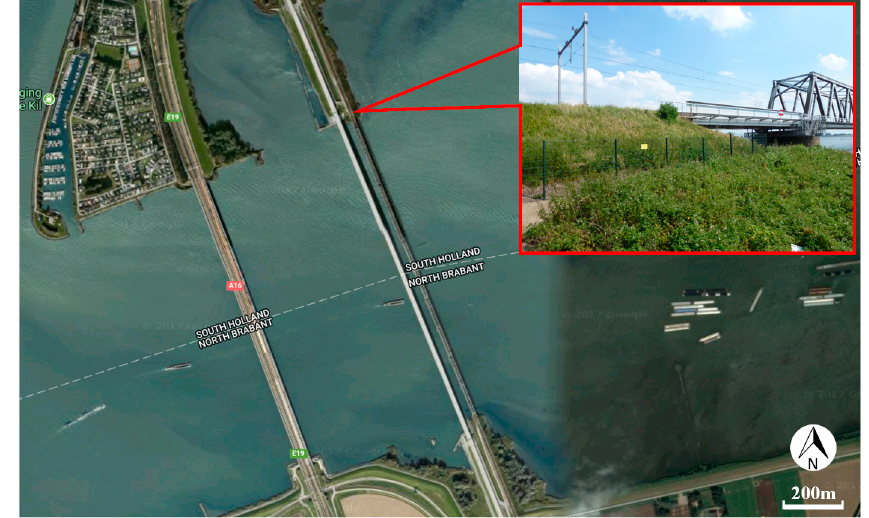
Figure 6. Photograph of the transition zone.